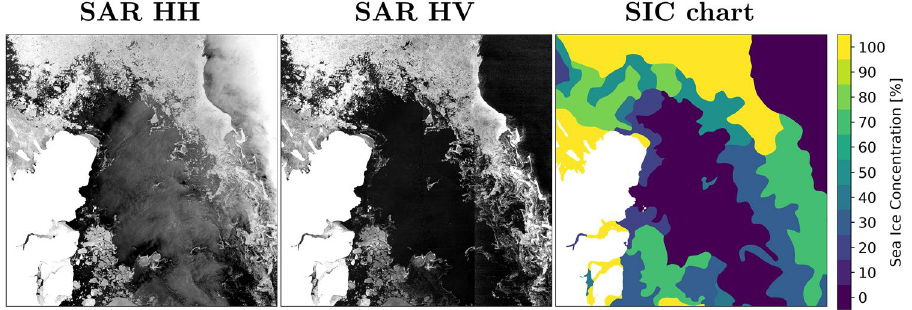
Figure 1. Sample scene—Fram Strait, Northeast Greenland. Scene acquired August 22, 2018. ( a , b ) HH and HV SAR images, respectively, with steep incidence angles on the right. ( c ) Corresponding human-drawn SIC chart (ground truth). White pixels indicate masked pixels in case of land or missing